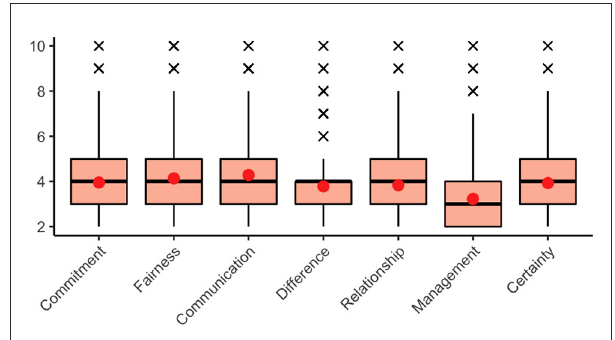
FIGURE1 Perceived relevance of the seven collaboration problems. The arithmetic mean value of the cumulative indices is shown as a red dot, the median as a thick horizontal line. Outlier values are represented by black crosses beyond the boxes. The graph is based on the survey data of n = 3,050 PIs and spokespersons after listwise deletion.